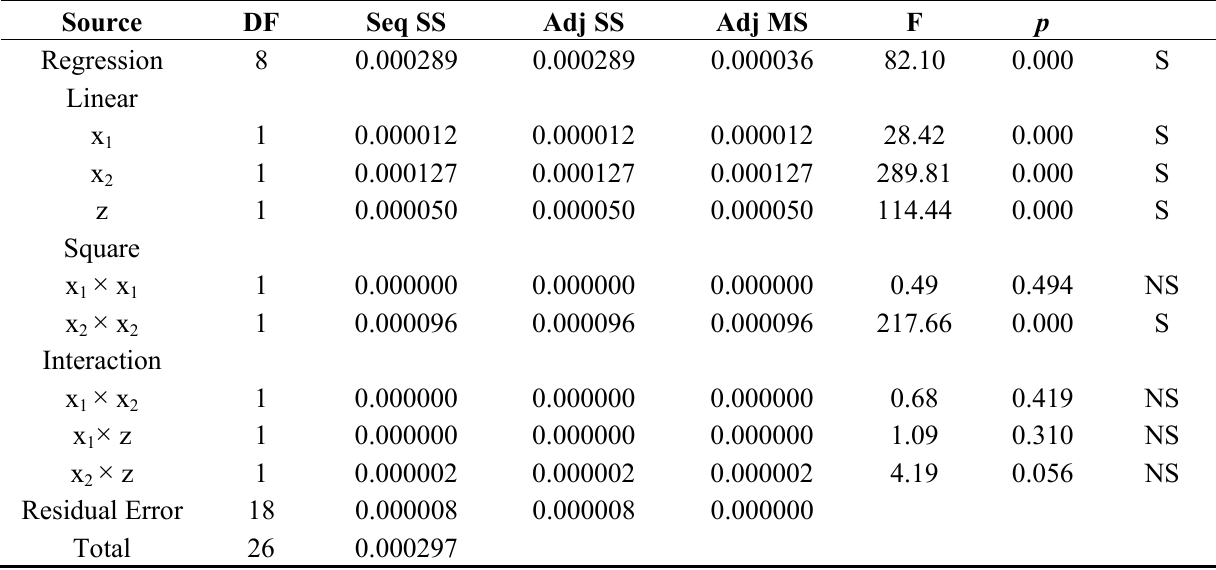
Table 5. ANOVA results for the experimental response at different factor